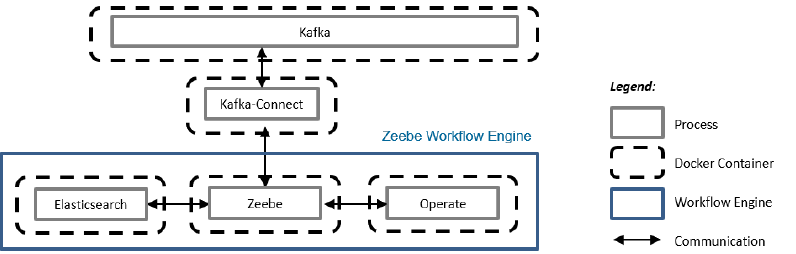
Figure 10. Zeebe workflow engine infrastructure.